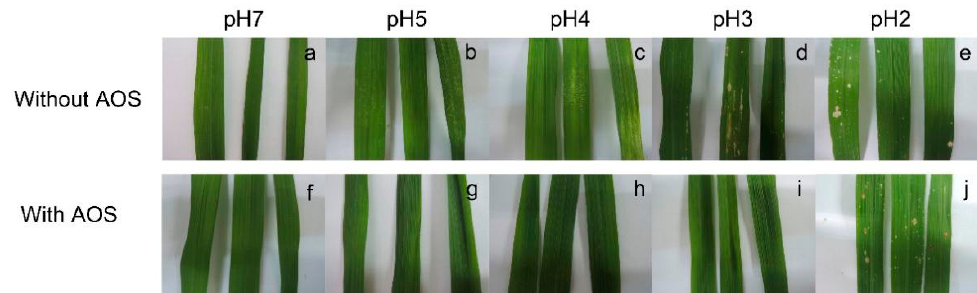
Figure 9. Leaves of rice seedlings exposed to different pH acid rain with and without foliar apply ‐ ing AOS for 7 days. ( a ‐ e ) The leaves subjected to normal temperature treatment. ( f ‐ j ) The leaves subjected to high temperature treatment. ( a , f ) The leaves with the control (pH 7) treatment. ( b , g ) The leaves with pH 5 acid rain treatment. ( c , h ) The leaves with pH 4 acid rain treatment. ( d , i ) The leaves with pH 3 acid rain treatment. ( e , j ) The leaves with pH 2 acid rain treatment.